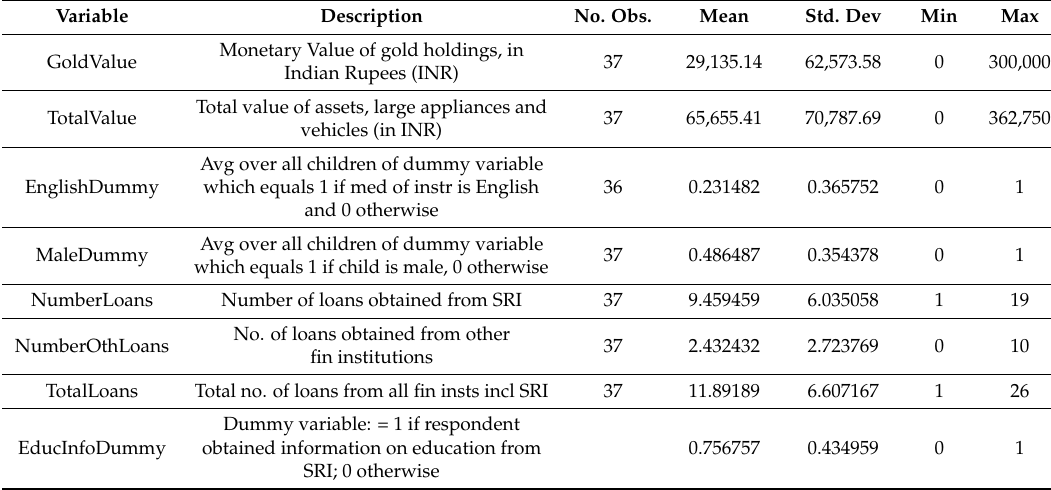
Table 2. Summary